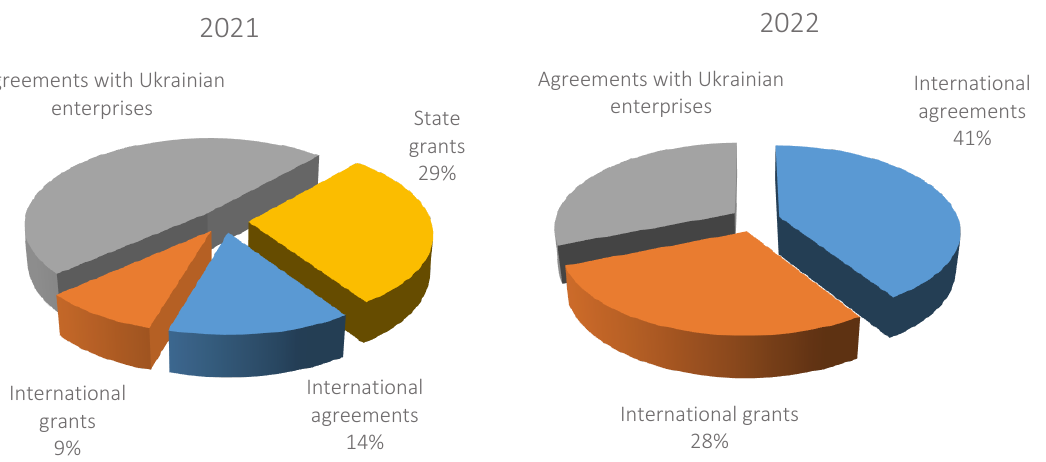
Figure A5. The revenue structure from the scientific activities at Sumy State